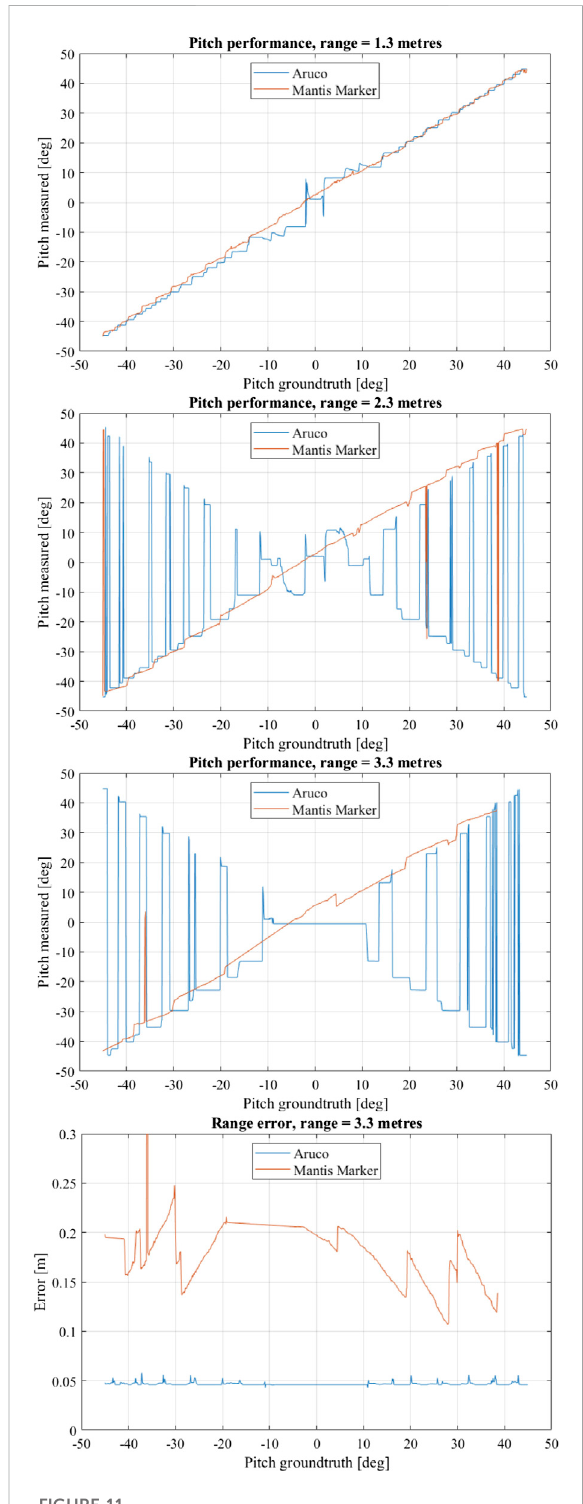
FIGURE 11 Performance evaluation results of virtual experiment. Shown are the pitch measurement vs. pitch ground truth at 3.3, 2.3 and 1.3 m, respectively. For these measurements, the fi ducial was only rotated along the pitch axis. In the bottom graph, range error vs. pitch ground truth at 3.3 m is